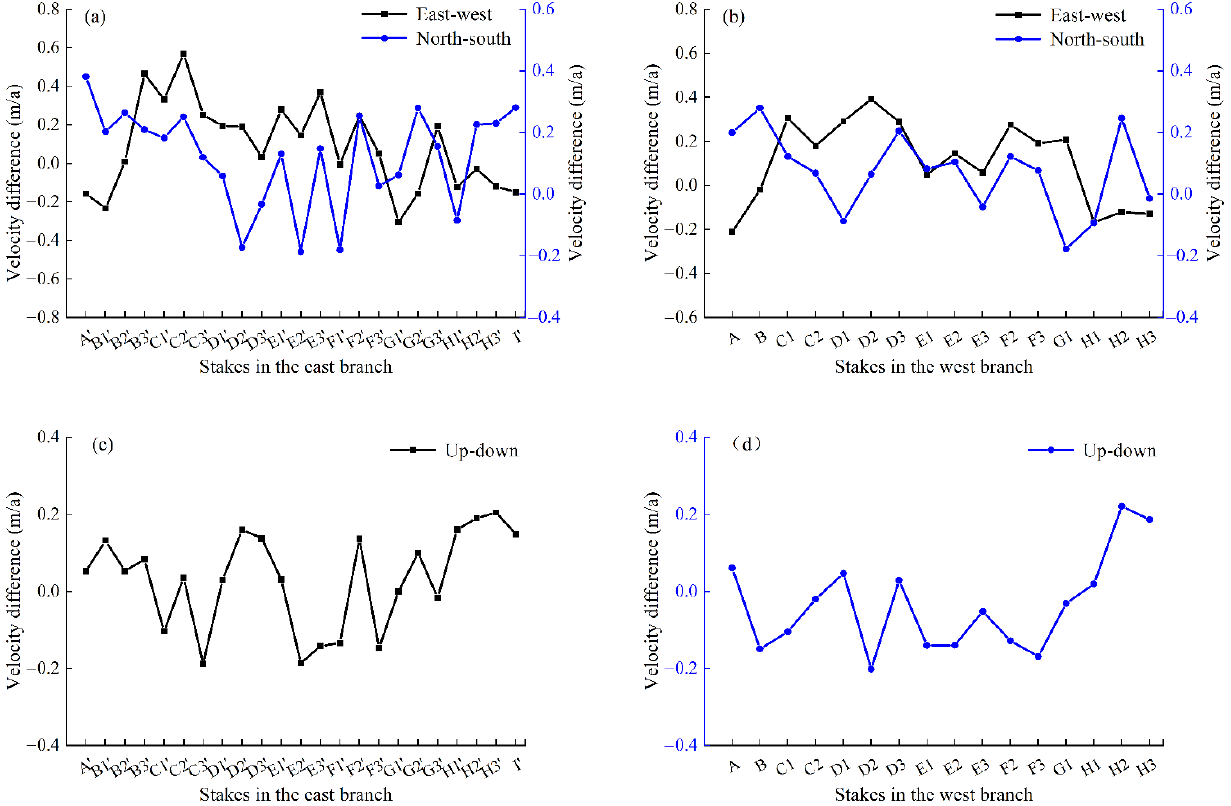
Figure 11. Difference between calculated and measured glacier flow velocity at the stakes. ( a , c ) show the velocity difference in the east branch. ( b , d ) show the velocity difference in the west branch.